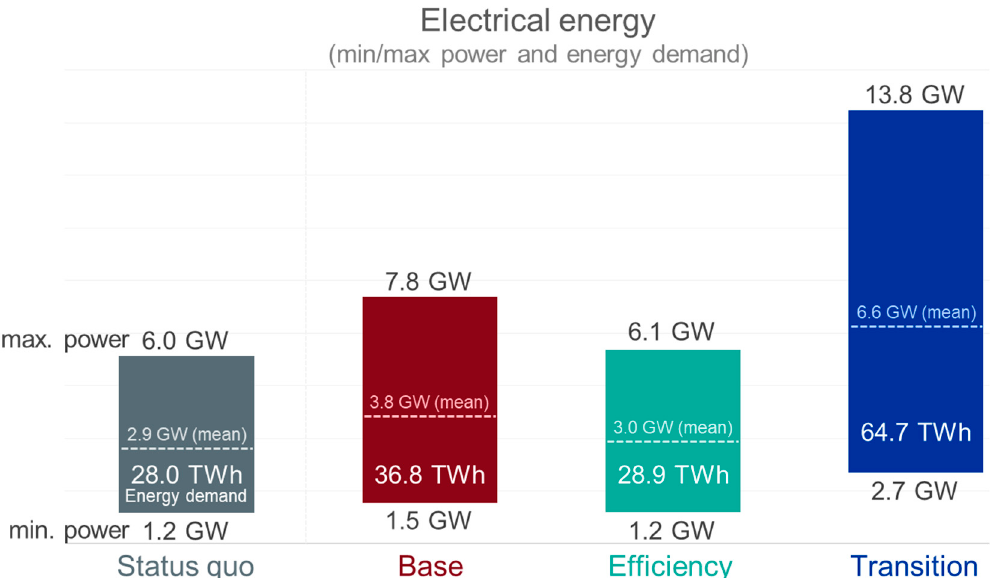
Figure 6. Electrical energy power data (min/max/mean) based on the considered industrial load profile in hourly resolution. In the respective bars the corresponding energy demands are indicated. The maximum power in each scenario is above the bar, the minimum power below.